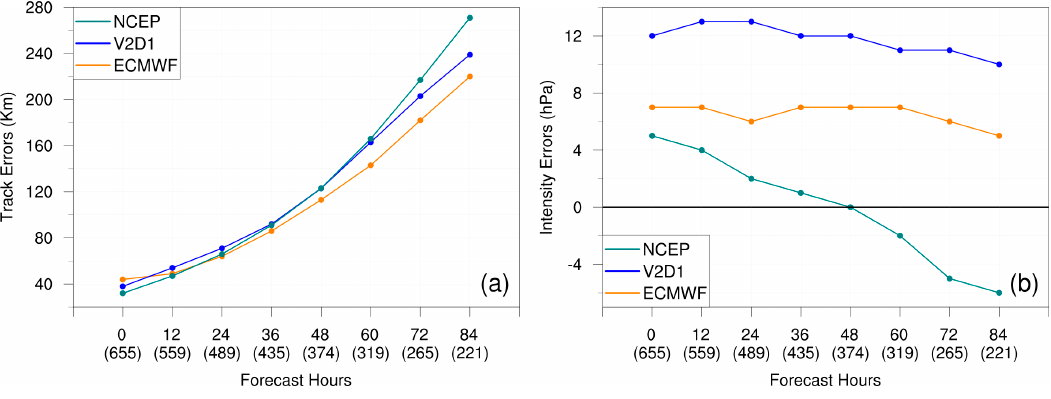
Figure 4. Multi-model comparisons among NCEP, ECMWF, and TWRF V2D1 include ( a ) track, ( b ) intensity (minimum center sea-level pressure) errors for 2016–2018 with a homogeneous sample. Note that the first two systems are global models. The numbers in parentheses along the x -axis denote the case numbers.